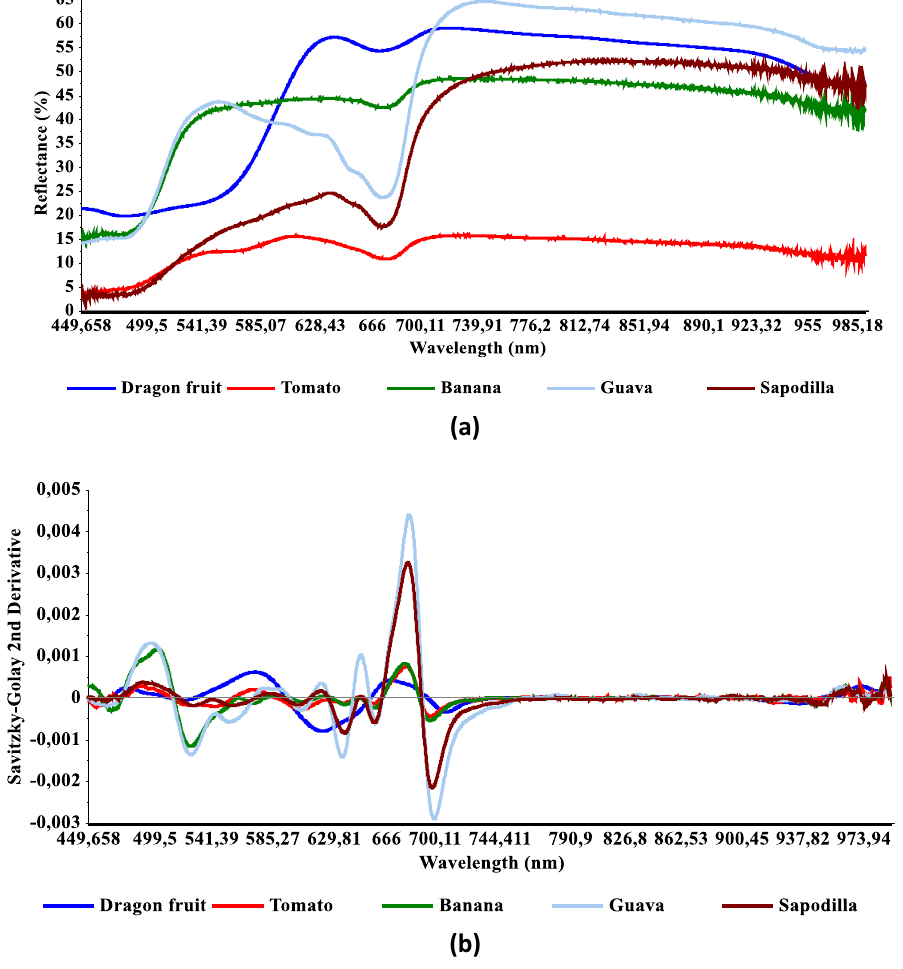
Figure 2: Re fl ectance spectra of dragon fruit, tomato, banana, guava, and sapodilla developed using ( a ) original spectra and ( b ) SGD2